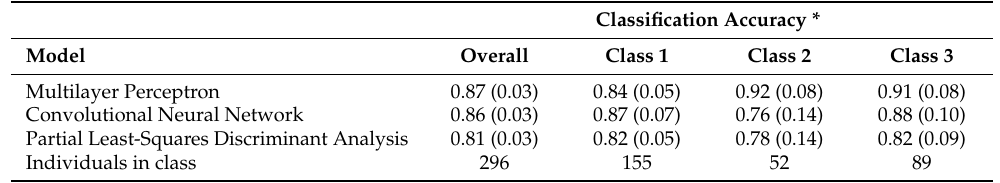
Table 3. Accuracy results of the spectral-based classification of genetically differentiated groups (subpopulations or genetic classes) performed in a provenance–progeny trial of